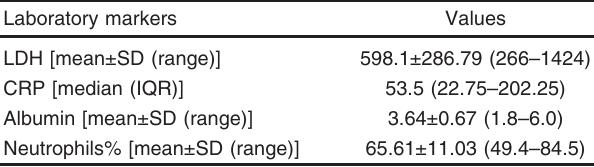
Table 2 Mean values of laboratory markers in the studied patients Laboratory markers